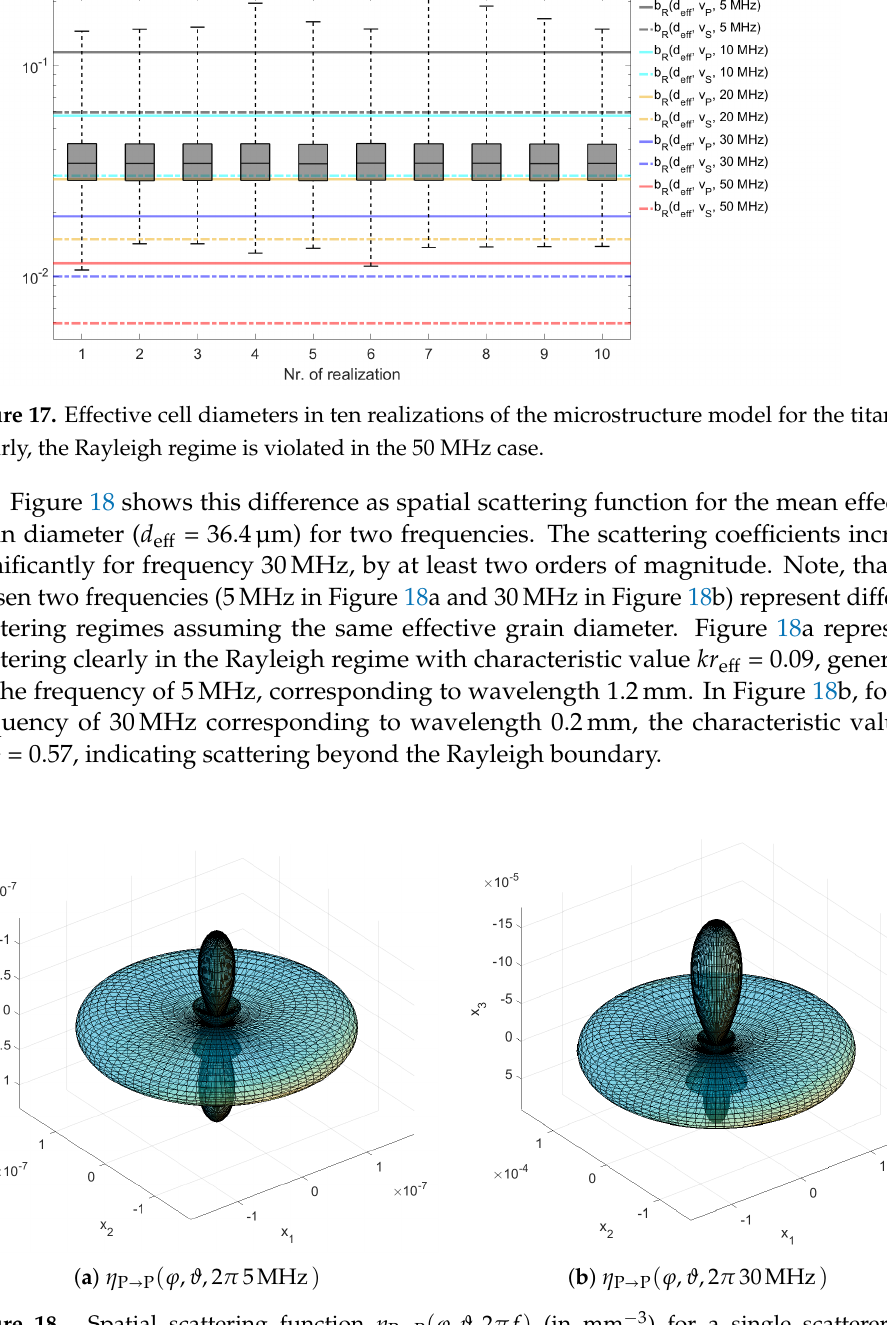
Figure 18. Spatial scattering function η P d eff = 36.4µm, testing frequency ( a ) f = 5 MHz, d eff π f / v α = 0.09 and ( b ) f = 30 MHz, d eff π f / v α = 0.57, respectively. Thus, according to Equation (16), for f = 30 we are in the stochas- tic